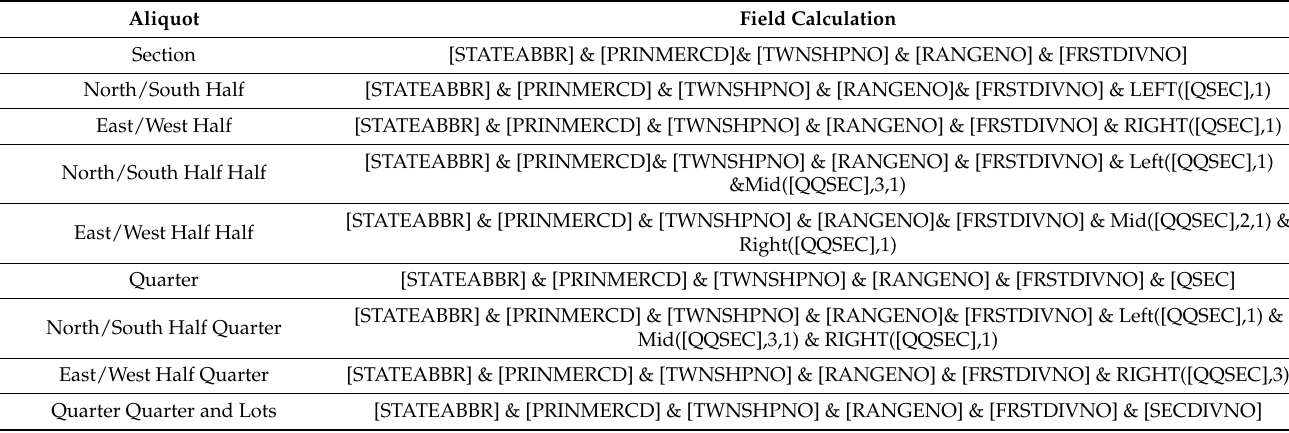
Table 2. Example Field Calculations performed in GIS on the PLSS Intersected base layer. This generates Unique IDs for various parcel aliquots. A dissolve function is later performed using the Unique IDs, thus generating the final parcel shape. This is step 3 in Figure